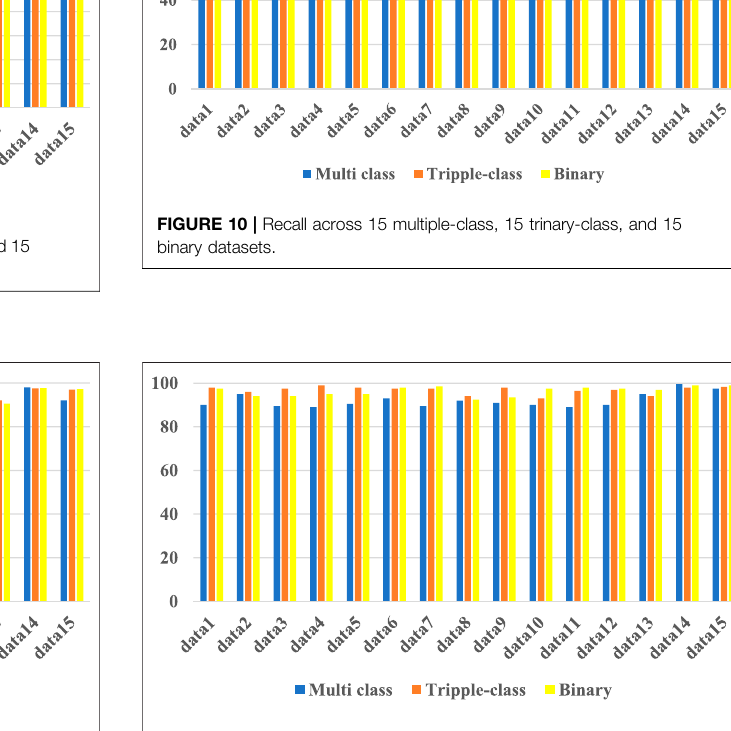
FIGURE 9 | Precision across 15 multiple-class, 15 trinary-class, and 15 binary datasets.